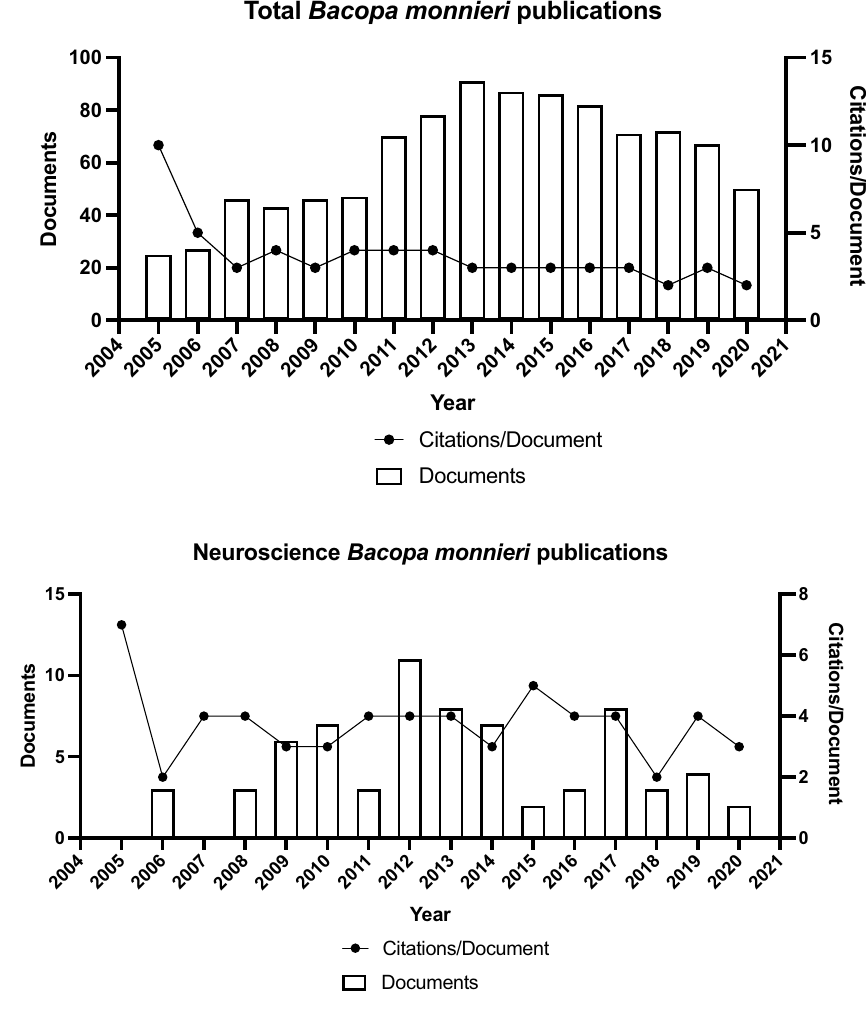
Figure 2. B . monnieri publication and citation history for the last 15 years (data extracted from